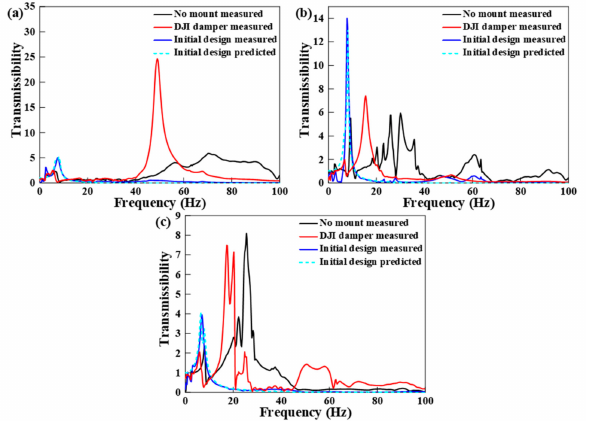
Figure 6. Comparison of transmissibility before and after applying mount elements: ( a ) fore-after direction, ( b ) side-by-side direction, and ( c ) vertical